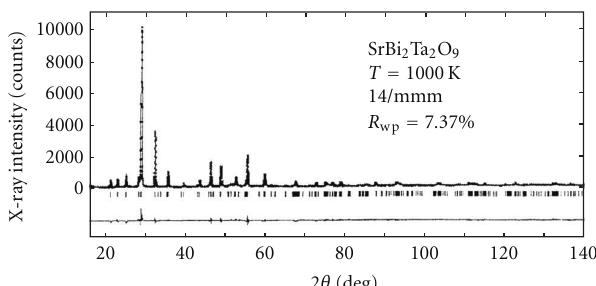
Figure 8: X-ray di ff raction patterns of SrBi 2 Ta 2 O 9 (CuK α ) at 1000 K [25].